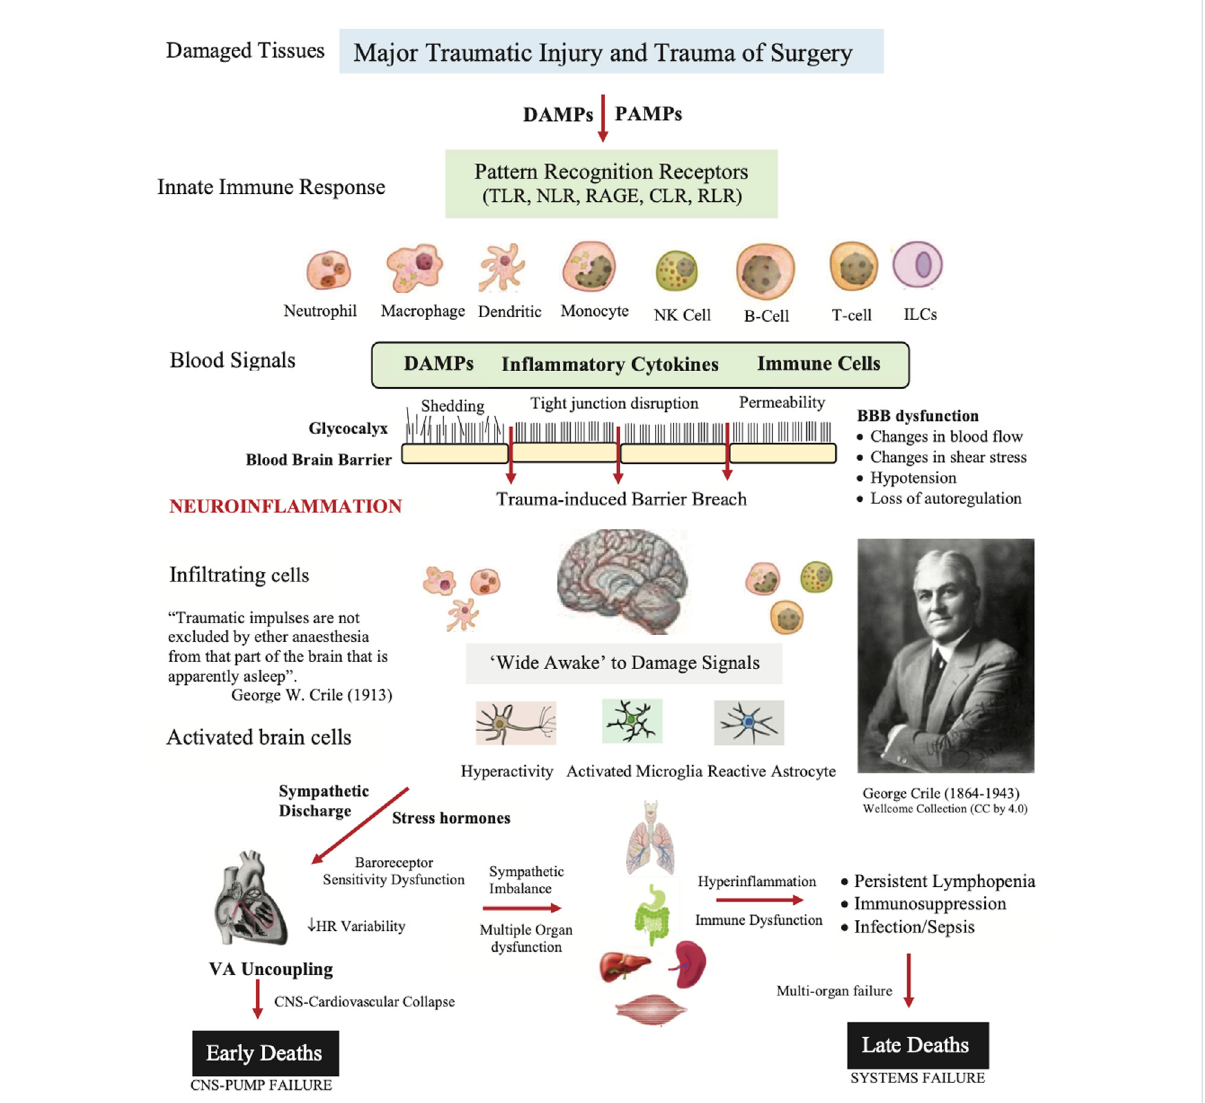
FIGURE 2 Role of damage associated molecular patterns (DAMPs), pathogen associated molecular patterns (PAMPs), neural signals, and other immune- modifying triggers on disrupting the blood brain barrier (BBB) and causing secondary injury following trauma. The innate immune response involves activation of pattern recognition receptors (PRRs) on resident and blood-borne immune cells including Toll-like receptors (TLRs), C-type lectin receptors (CLRs), nucleotide-binding oligomerization domain (NOD)-like receptors (NLRs), retinoic-acid-inducible gene-I (RIG-I)-like receptors(RLRs),andreceptorforadvancedglycationend products (RAGE). The brainand immune cellsorchestrate therightresponse byactivating neural circuits, and releasing hormones, cytokines and other immuno-in fl ammatory factors. If dysregulation is persistent, the response can overwhelm the system and lead to multiple organ dysfunction syndrome (MODS) and late deaths. The patient ’ s response to the trauma of surgery may also contribute to a systems failure (see text). ARDS, acute respiratory distress syndrome; HR, heart rate; ILC, innate lymphoid cell; NK, natural killer